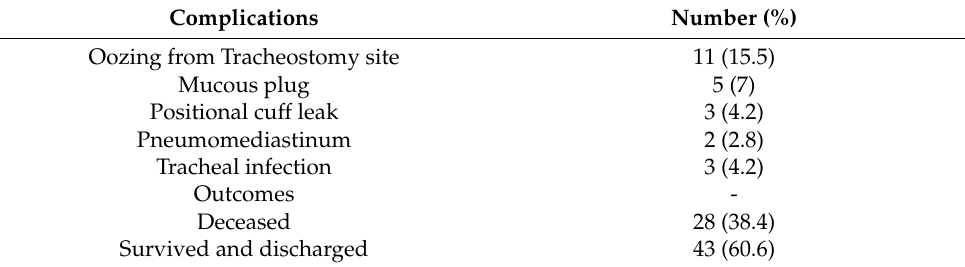
Table 4. COVID-19 tracheostomy complications and